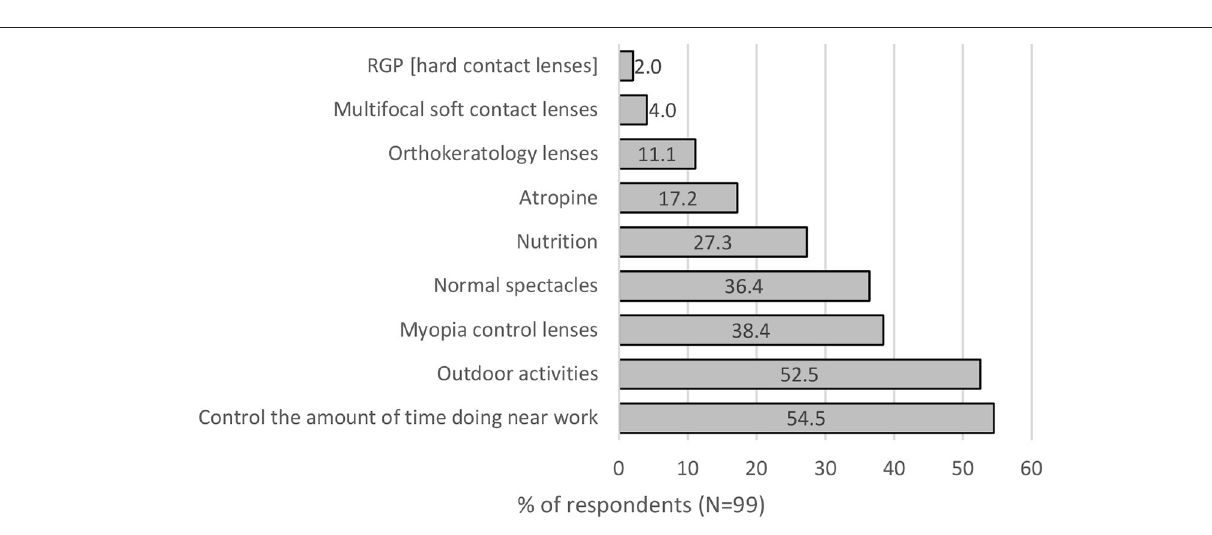
FIGURE 4 | Perceived effectiveness of myopia control interventions by